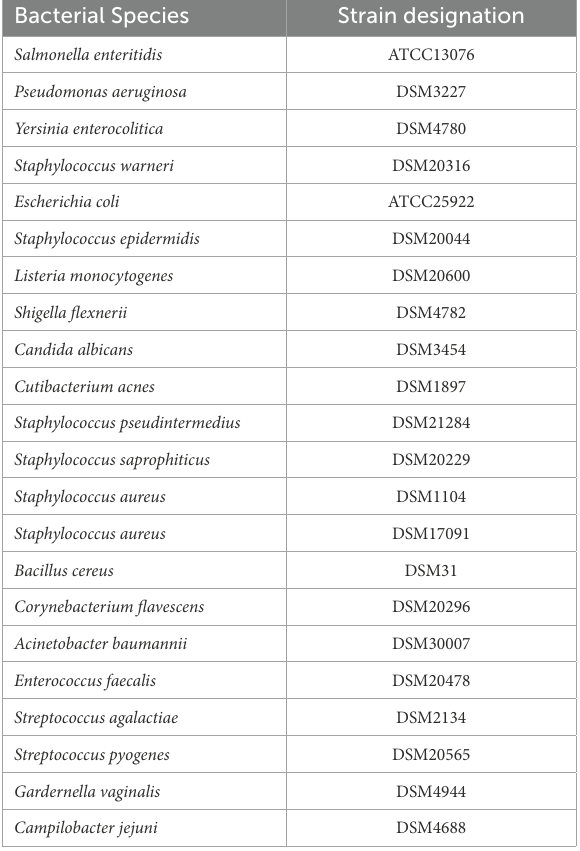
TABLE 1 Indicator strains used in this